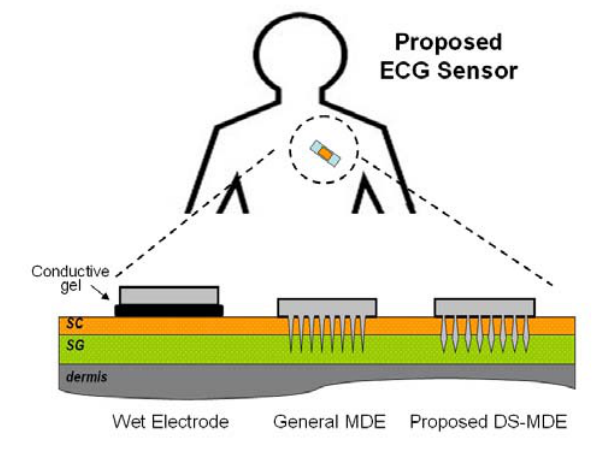
Figure 2. The proposed ECG sensor for bio-signal measurements.